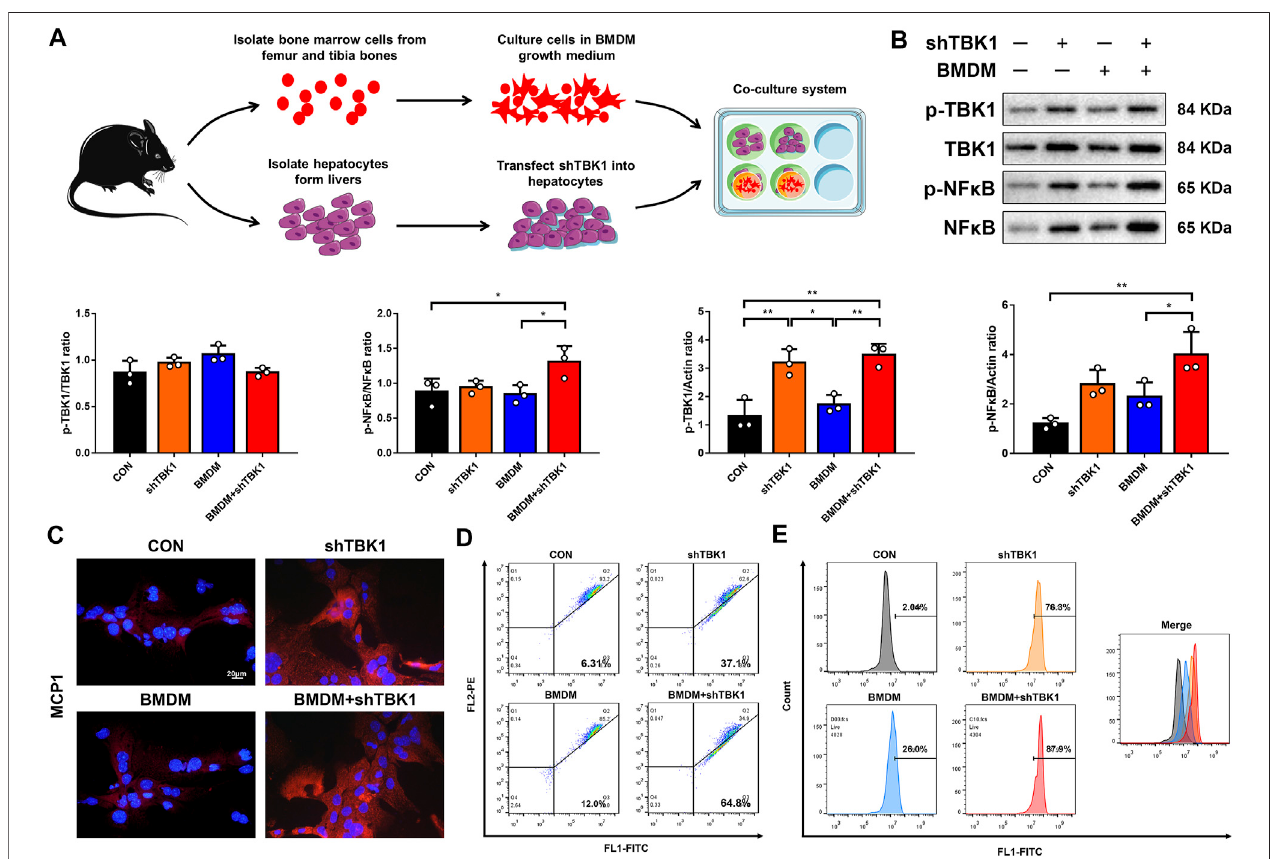
FIGURE 6 | TBK1 promoted NF κ B-MCP1 signaling pathway. (A) The schematic diagram of co-culture system for hepatocytes and BMDMs. (B) Western blot analyses of p-TBK1, TBK1, p-NF- κ B and NF- κ B in hepatocytes and statistical graphs, n (cid:1) 3. (C) Immuno- fl uorescence staining of MCP1. (D) The mitochondrial membrane potential assay was detected by JC-1, three samples were collected together for testing, and the experiment was repeated three times. (E) The ROS assay was detected with DCFH-DA, three samples were collected together for testing, and the experiment was repeated three times. Results are presented as means ±